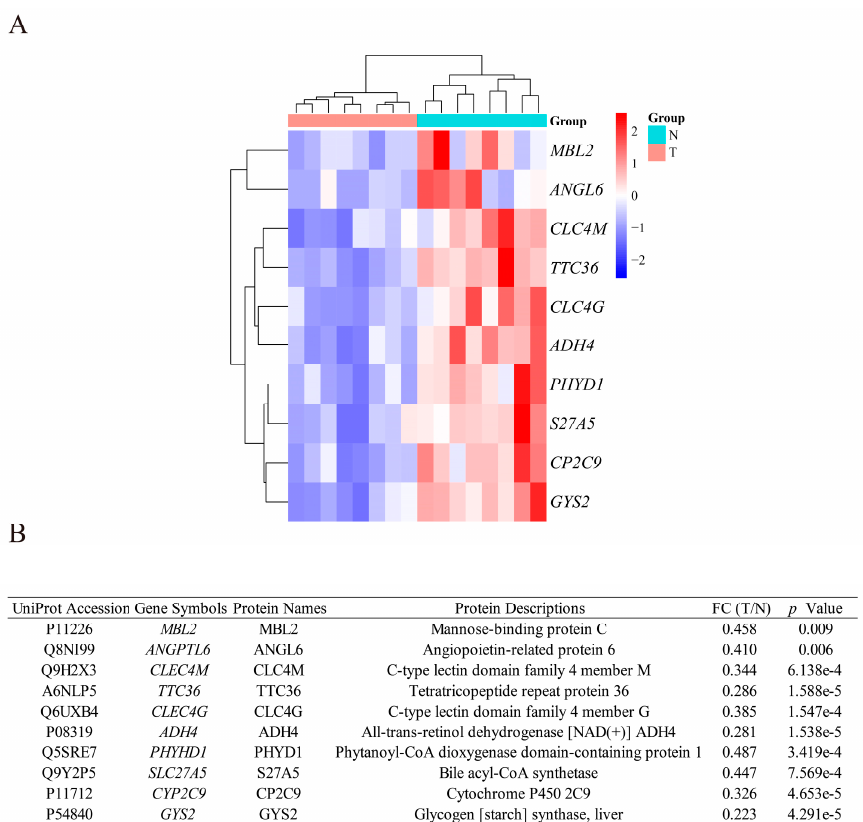
Figure 4. The heatmap of 10 DEPs between HCC tissues and paired adjacent nontumorous tissues. ( A ) The heatmap of 10 DEPs. ( B ) The annotated information of the DEG-encoded proteins. Abbreviations : ADH4 , alcohol dehydrogenase 4 (class II), pi polypeptide; ANGPTL6 , angiopoietin- like 6; CLEC4G , C-type lectin domain family 4 member G; CLEC4M , C-type lectin domain family 4